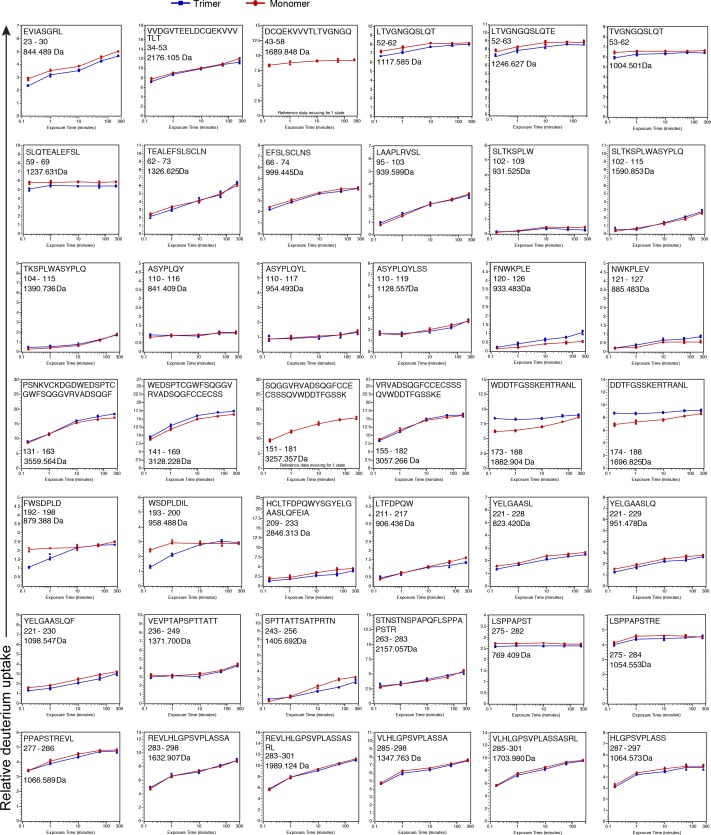
Deuterium incorporation plots for all 120 peptic peptides that were compared between the monomer (red) and trimer (blue).On the x axis is the time in minutes and on the y-axis is the relative uptake (Da). The maximum y-axis value for each plot represents the theoretical maximum amount of D that can be incorporated into a peptide. Values represent the mean of three individual measurements; error bars, s.d.